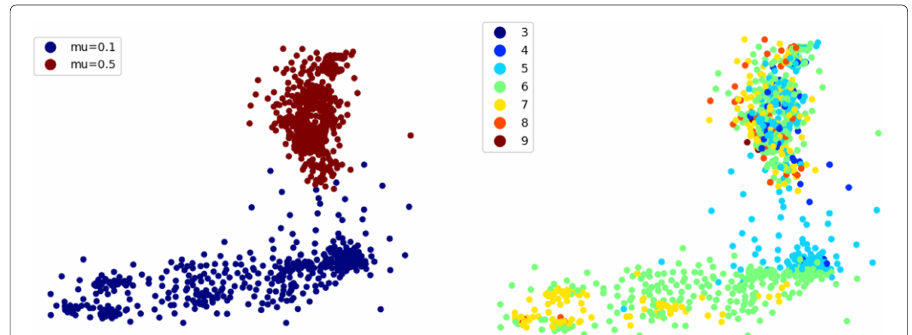
Fig. 5 Visualization of networks generated with the LFR benchmark. (Left) networks with different community strength: μ = 0.1 and μ = 0.5. (Right) Same left-hand side networks. Colors encode the number of planted communities within each network